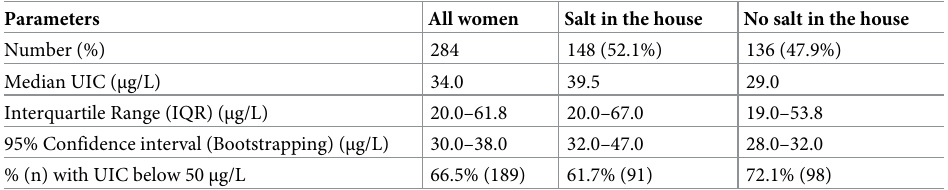
Table 2. Summary statistics of the urinary iodine concentration ( μ g/L) for all women, and for those with salt in the house and no salt in the house. Parameters